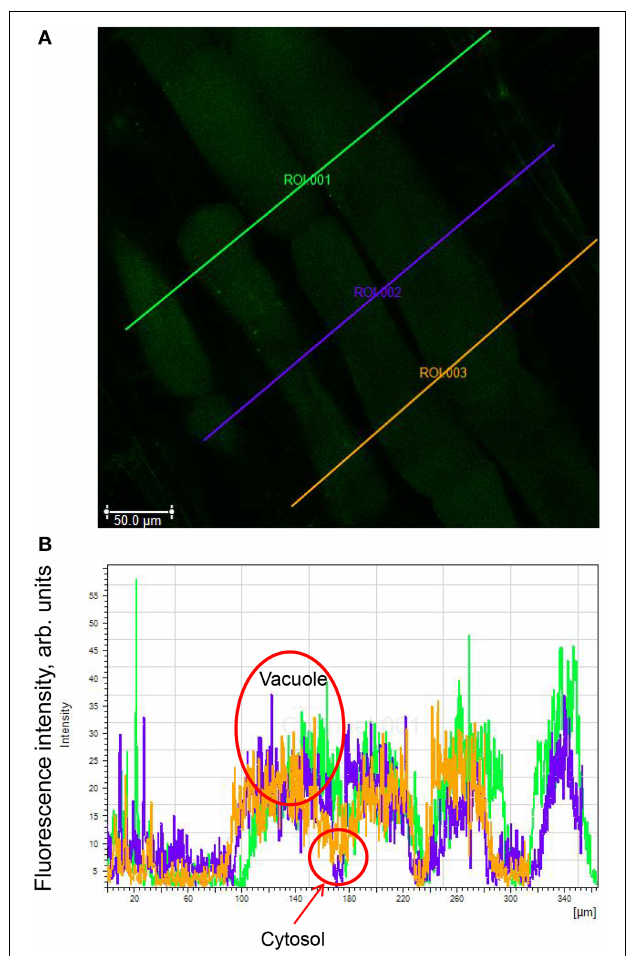
FIGURE 1 | Illustration of the quantification procedure for Na + distribution between the cytosol and the vacuole. (A) Several lines are drawn across the so-called “region of interest” (ROI) in an appropriate root zone. (B) Continuous fluorescence intensity distribution profiles obtained by LAS software. The mean fluorescence intensity values for cytosolic and vacuolar compartments are then calculated for each cell by attributing signal profiles to root morphology (visualized by light microscopy images; not shown in a figure). The shown image was obtained from mature region of Persia 118